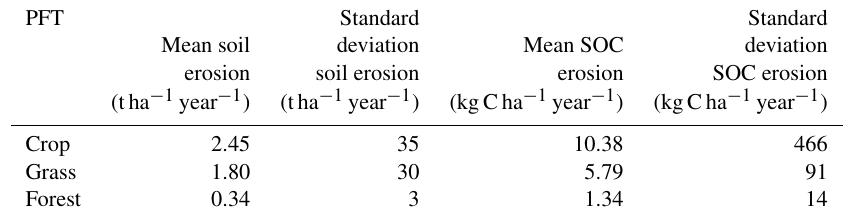
Table 2. Area-weighted average and standard deviation of soil and SOC erosion rates per land cover type for the year AD2005; the uncer- tainty range for soil erosion rates is 25%–53 % and for SOC erosion rates 16%–50%.